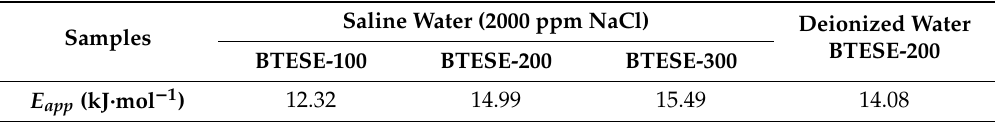
Table 4. Apparent activation energy E app for water permeation through the BTESE